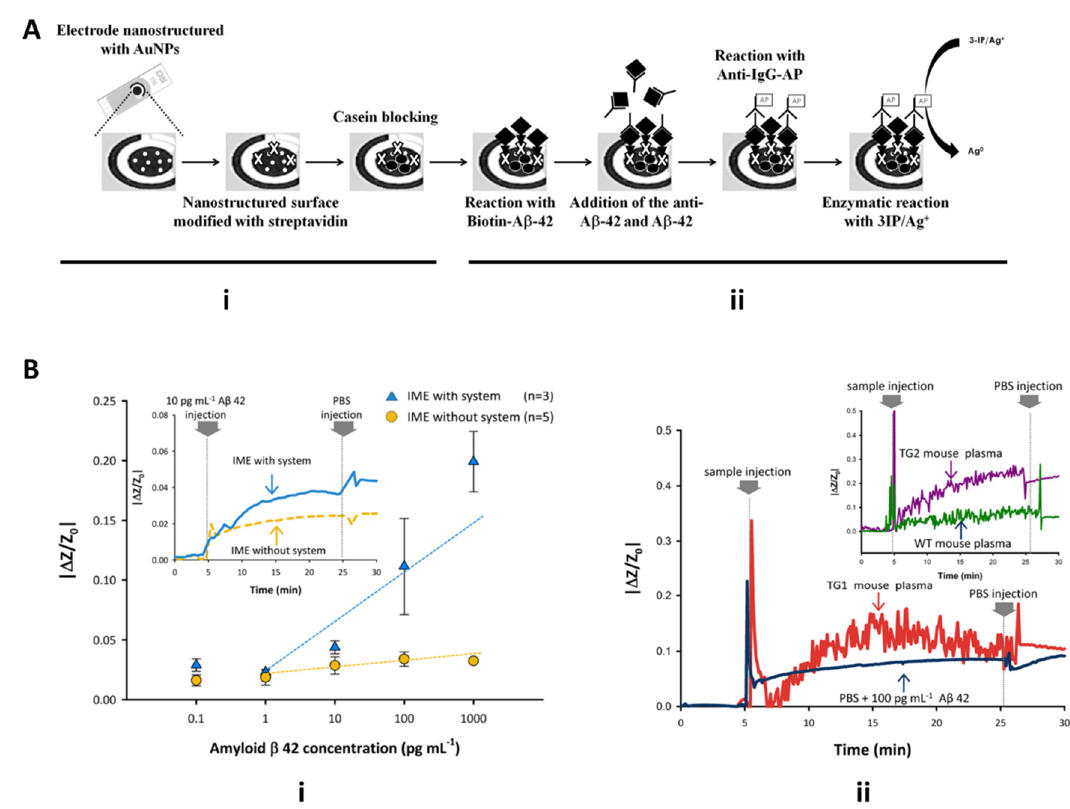
Figure 9. Microfluidic devices for detection of Alzheimer’s disease biomarkers. ( A ) Schematic of Costa Rama electrochem- ical immunosensor for detection of amyloid-beta. Sensing electrode features streptavidin-modified gold nanoparticles increase exosomal surface interaction for detection with anti-A β and cyclic voltammetry (adapted with permission from Costa Rama et al., 2014 and provided by Elsevier and Copyright Clearance Center. ( B ) Yoo 2017 interdigitated microelec- trode sensor (IME) and impedimetric sensor readout for detection A β with and without SCAP system and PBS buffer exchange (reprinted under open access within Creative Commons CC BY license, Springer Nature).